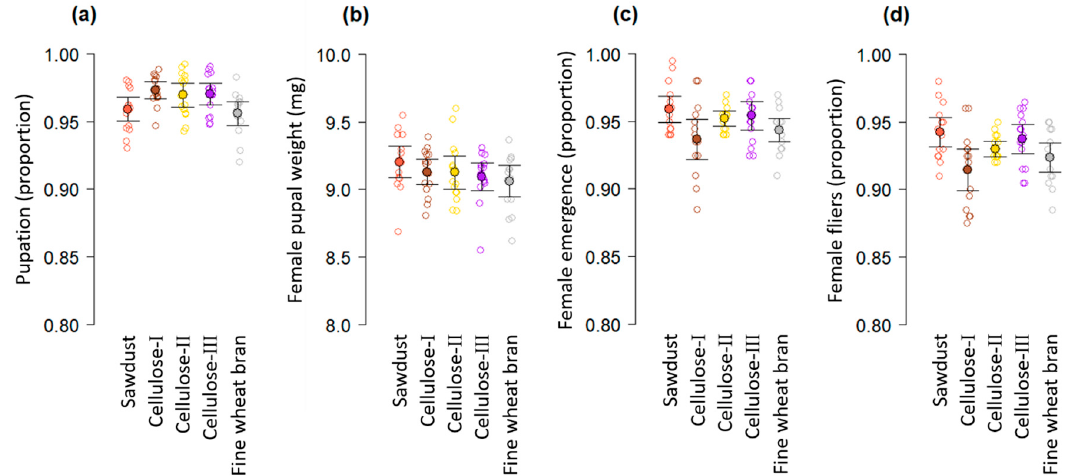
Figure 2. Mean of ( a ) pupation, ( b ) female pupal weight, ( c ) female emergence (proportion) and ( d ) female fliers (proportion) of C. capitata VIENNA 8 GSS as a function of the type of pupation substrate. Open symbols indicate jittered data points, solid symbols average values and the error bars indicate 95% confidence intervals.